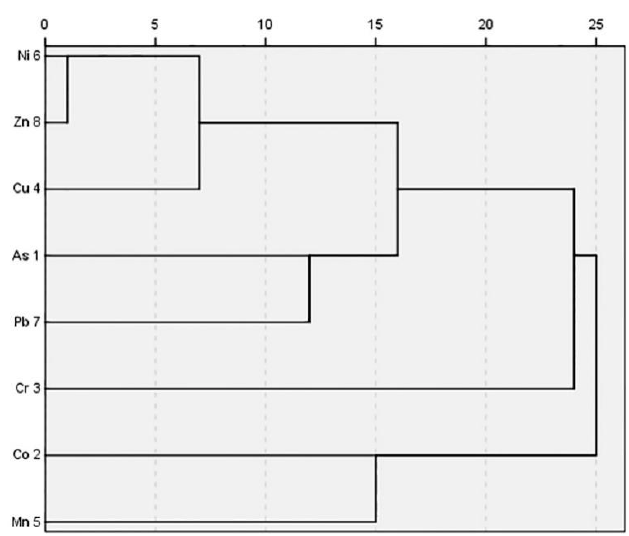
Figure 7. Dendrogram of PHEs concentrations in 0–40 cm soil layer.